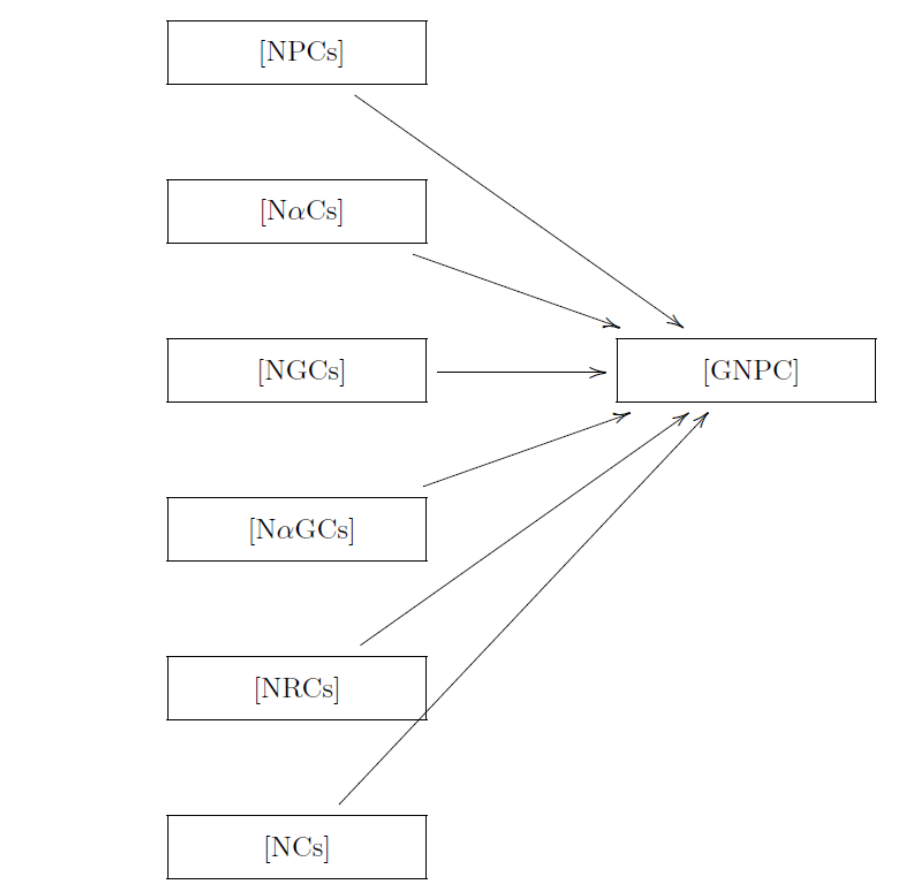
Figure 1. Relation between GNPC and others exists